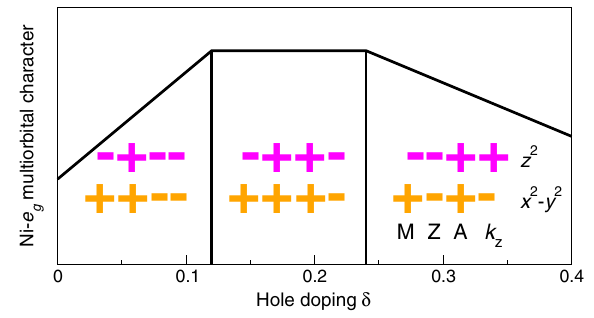
multiorbital character FIG. 14. Comparison of electron ( δ < 0 ) vs hole ( δ > 0 ) doping g within the minimal-Hamiltonian picture for U ¼ 6 eV. From left to right: Orbital-resolved occupations, QP weights, and local in the z spin-spin correlations. The SD potential shift is set to μ